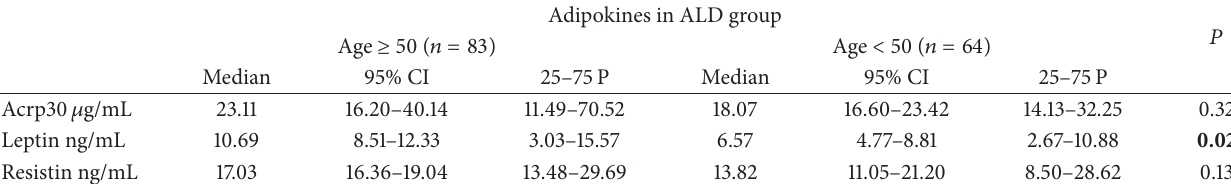
Table 5: Comparison of serum adipokine levels according to the age of patients with ALD.